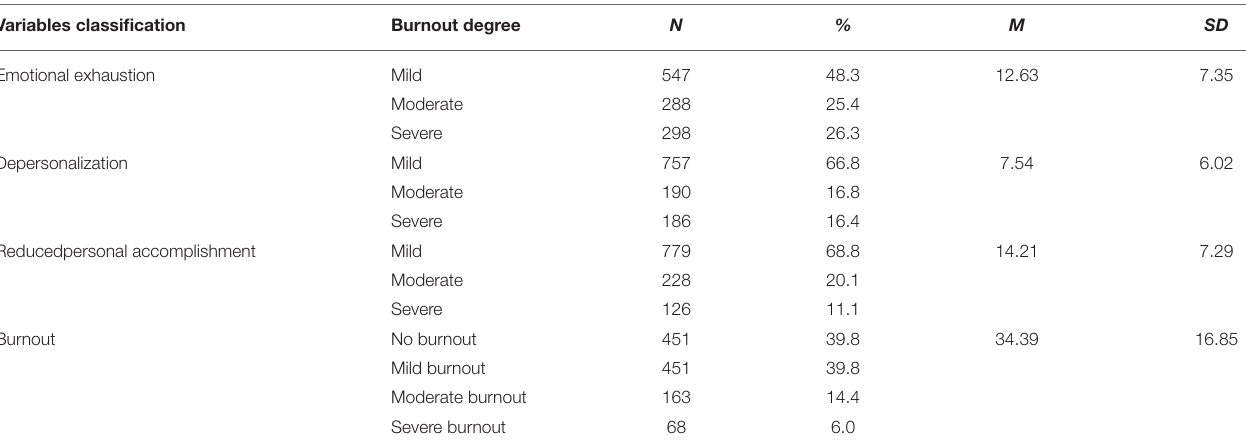
TABLE 3 | Values are numbers (percentages) of respondents regarding burnout ( n = 1,133). Variables